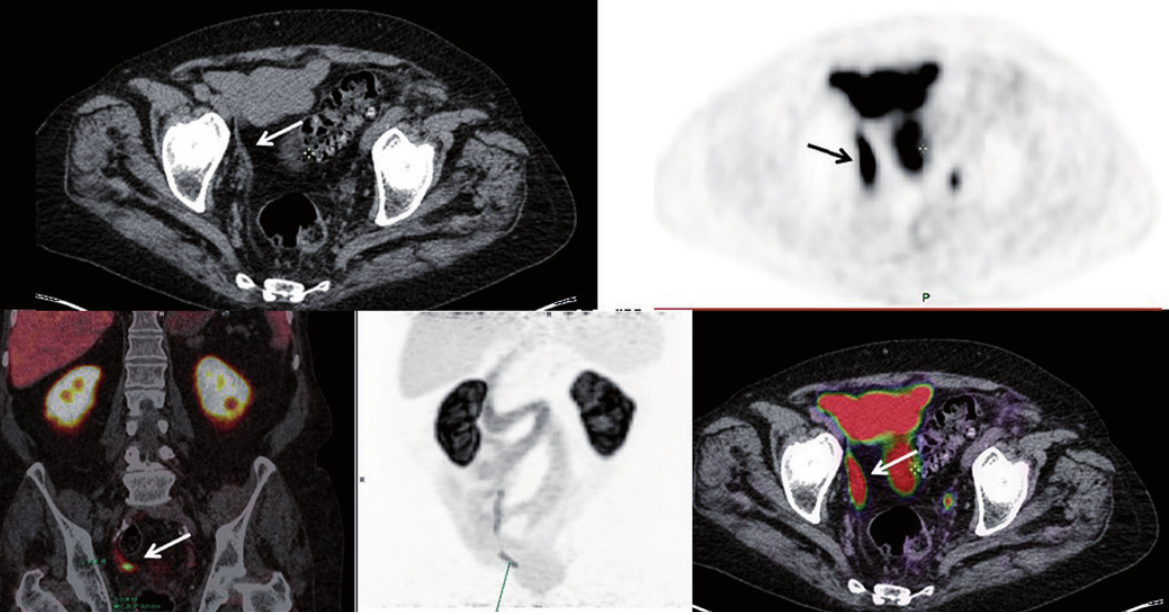
Figure 1 - Anomalous accumulation of PsMA-68Ga in the right vas deferens. That has increased dimension compared to the contralateral, suggestive of secondary neoplastic lesion found, considering the underlying